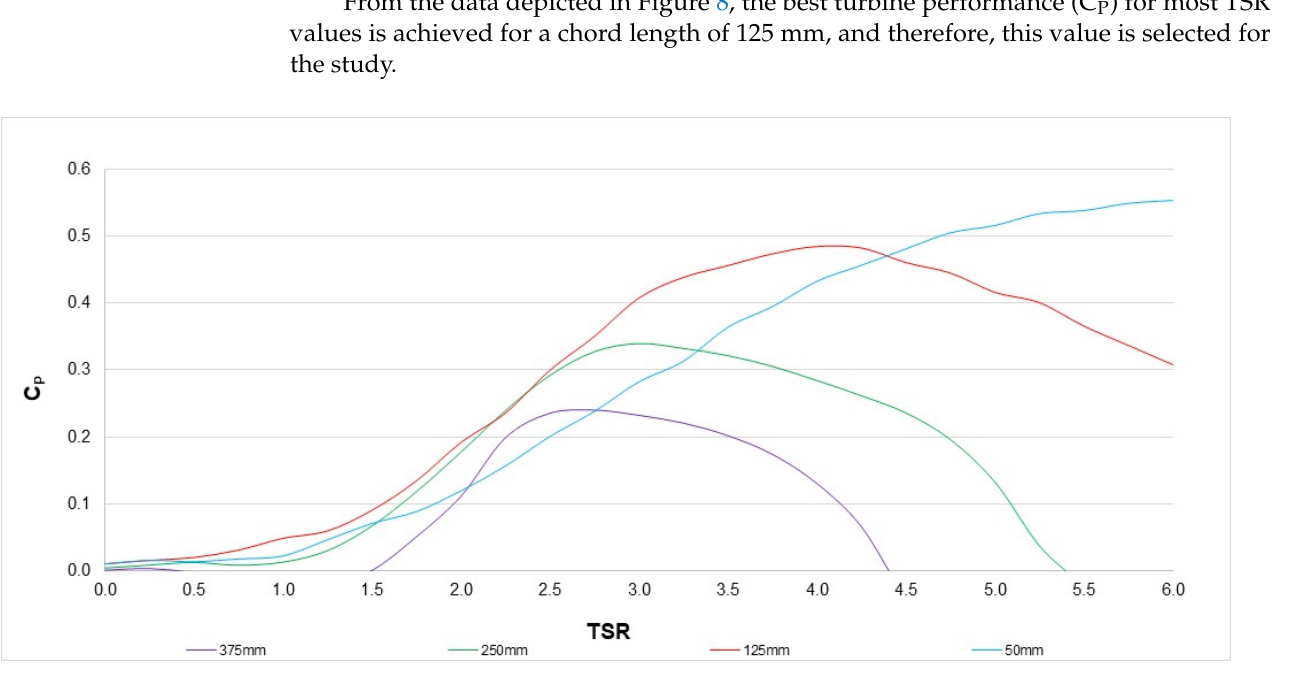
Figure 7. Coefficient of power vs. TSR plot for different chord lengths.